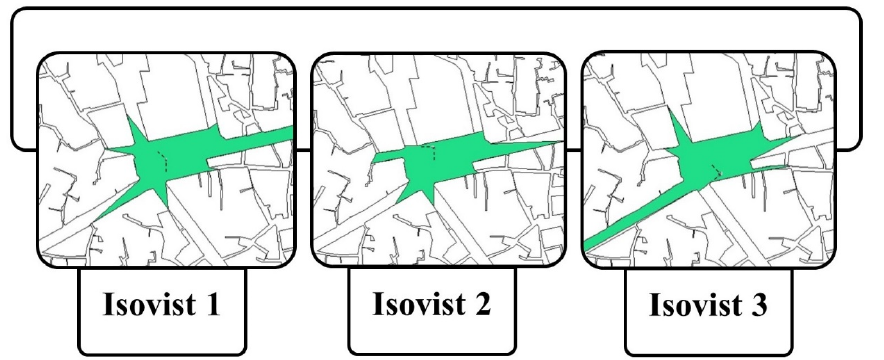
Figure 6. The obtained potential fields of view based on three positions towards the central square using Isovist graphs.